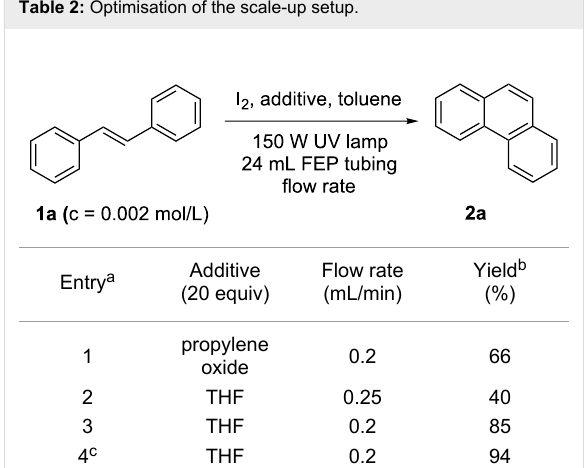
Table 2: Optimisation of the scale-up